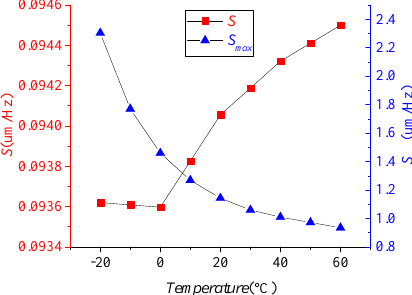
Figure 2. The mechanical sensitivity at different temperature (left red y -axis represents S and right blue y -axis represents S max